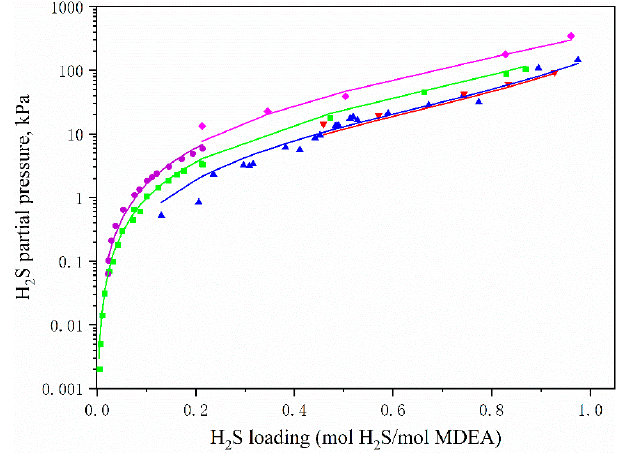
Figure 3. Comparison of experimental data and calculated data of the H 2 S–H 2 O–MDEA system under different conditions. ■ , measured by Jou et al. [43], T = 313.15 K, MDEA mass fraction = 0.35; ● , measured by Jou et al. [43], T = 313.15 K, MDEA mass fraction = 0.50; ▲ , measured by Macgregor and Mather [14], T = 310.95 K, MDEA mass fraction = 0.209; ▼ , measured by Qian et al. [44], T = 338.75 K, MDEA mass fraction = 0.20; and ◆ , measured by Qian et al. [44], T = 338.75 K, MDEA mass fraction = 0.20. The solid line represents the calculated data in this work.